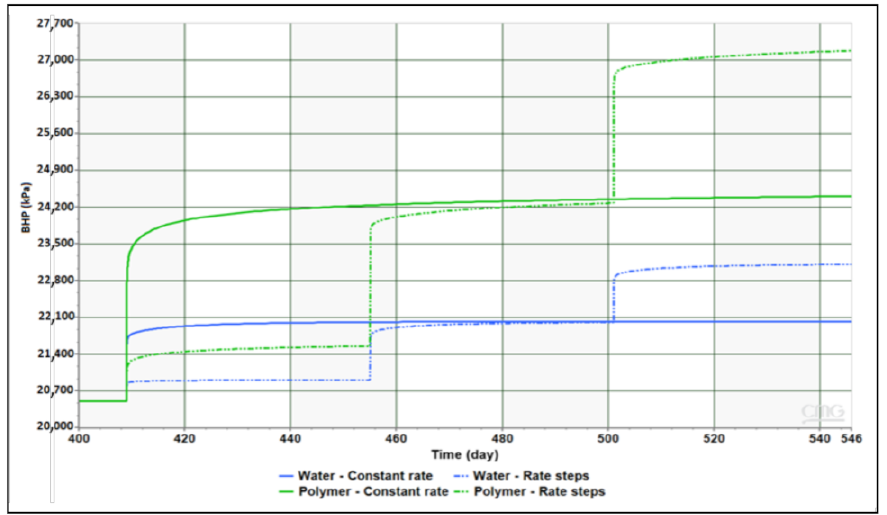
Figure 11. Impact of rate stepping on Newtonian and non-Newtonian